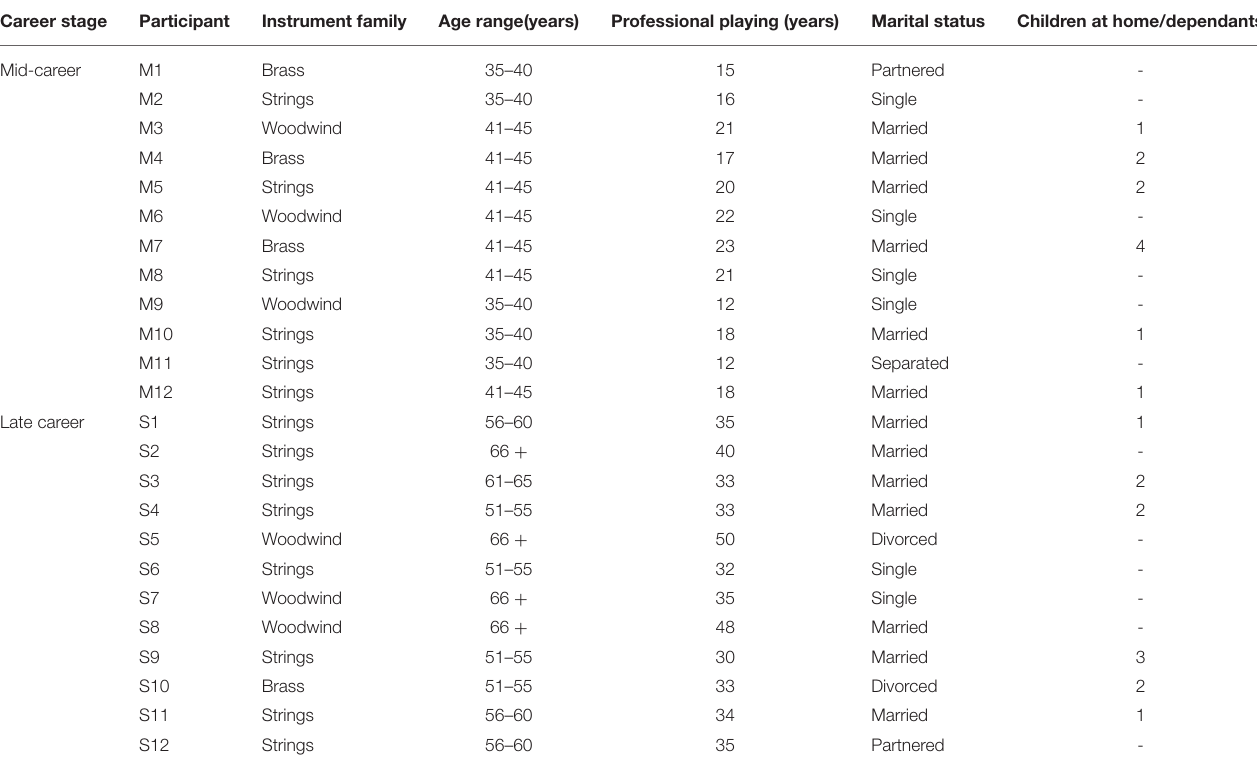
TABLE 1 | Summary of participant